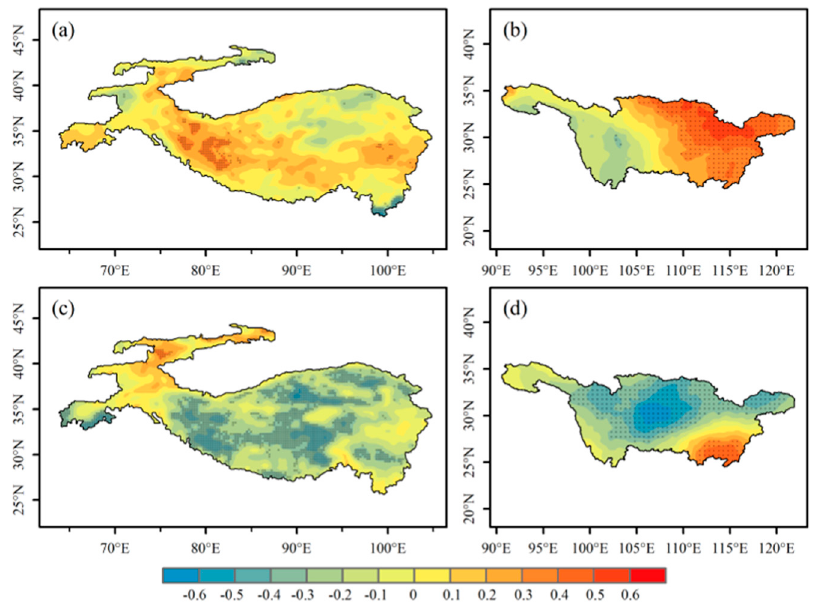
Figure 10. The spatial distributions of the left and right fields of the first SVD mode, derived from winter snow depth of HMA and the succeeding spring and summer precipitation of YRB during the period 1980–2019. ( a , b ) and ( c , d ) represent spring and summer, respectively, and the dotted area means passing significance test of 0.05.